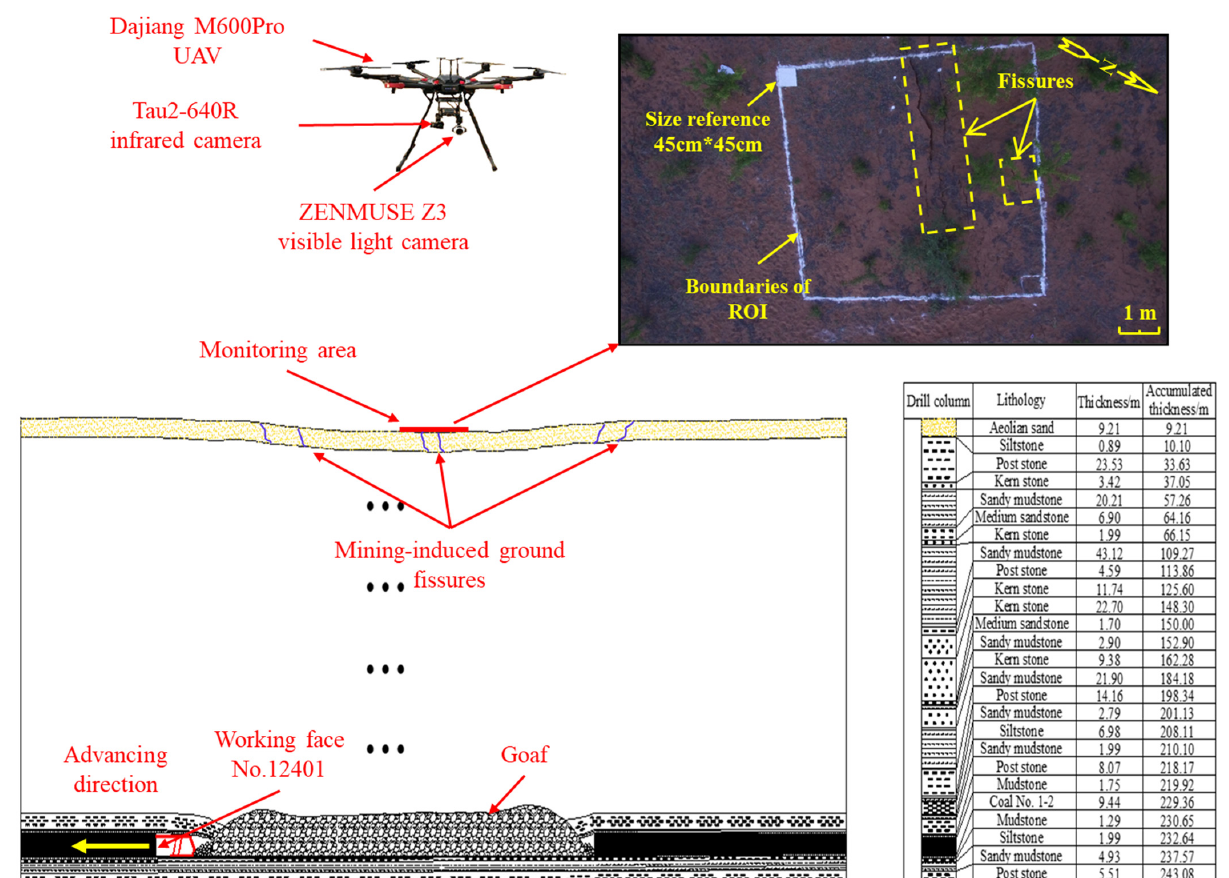
Figure 1. Schematic diagram of UAV monitoring of mining-induced ground fissures .